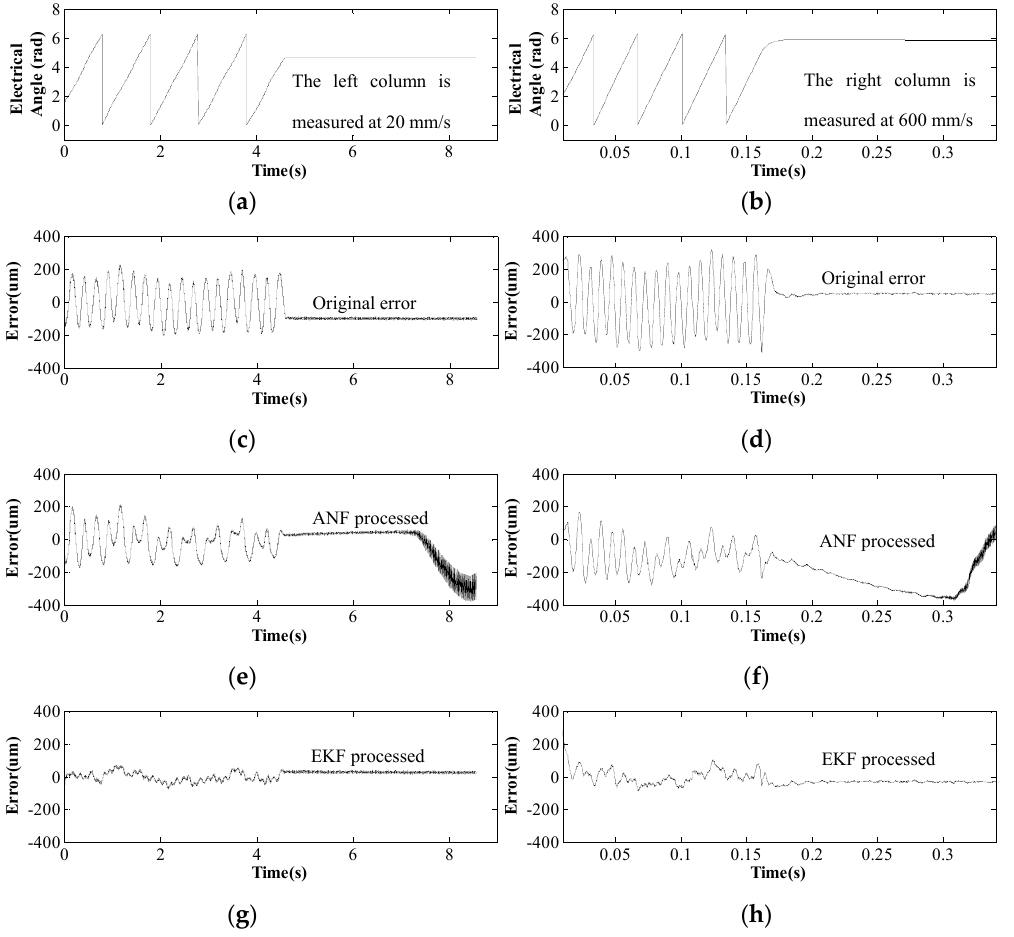
Figure 9. Position detection error at 20 mm/s and 600 mm/s. ( a , b ) Electrical angle of PMTLM. ( c , d ) Position detection error when using original sensor signals. ( e , f ) Error when using ANF processed signals. ( g , h ) Error when using EKF processed signals. The left column is measured at 20 mm/s, and the right column is measured at 600 mm/s.